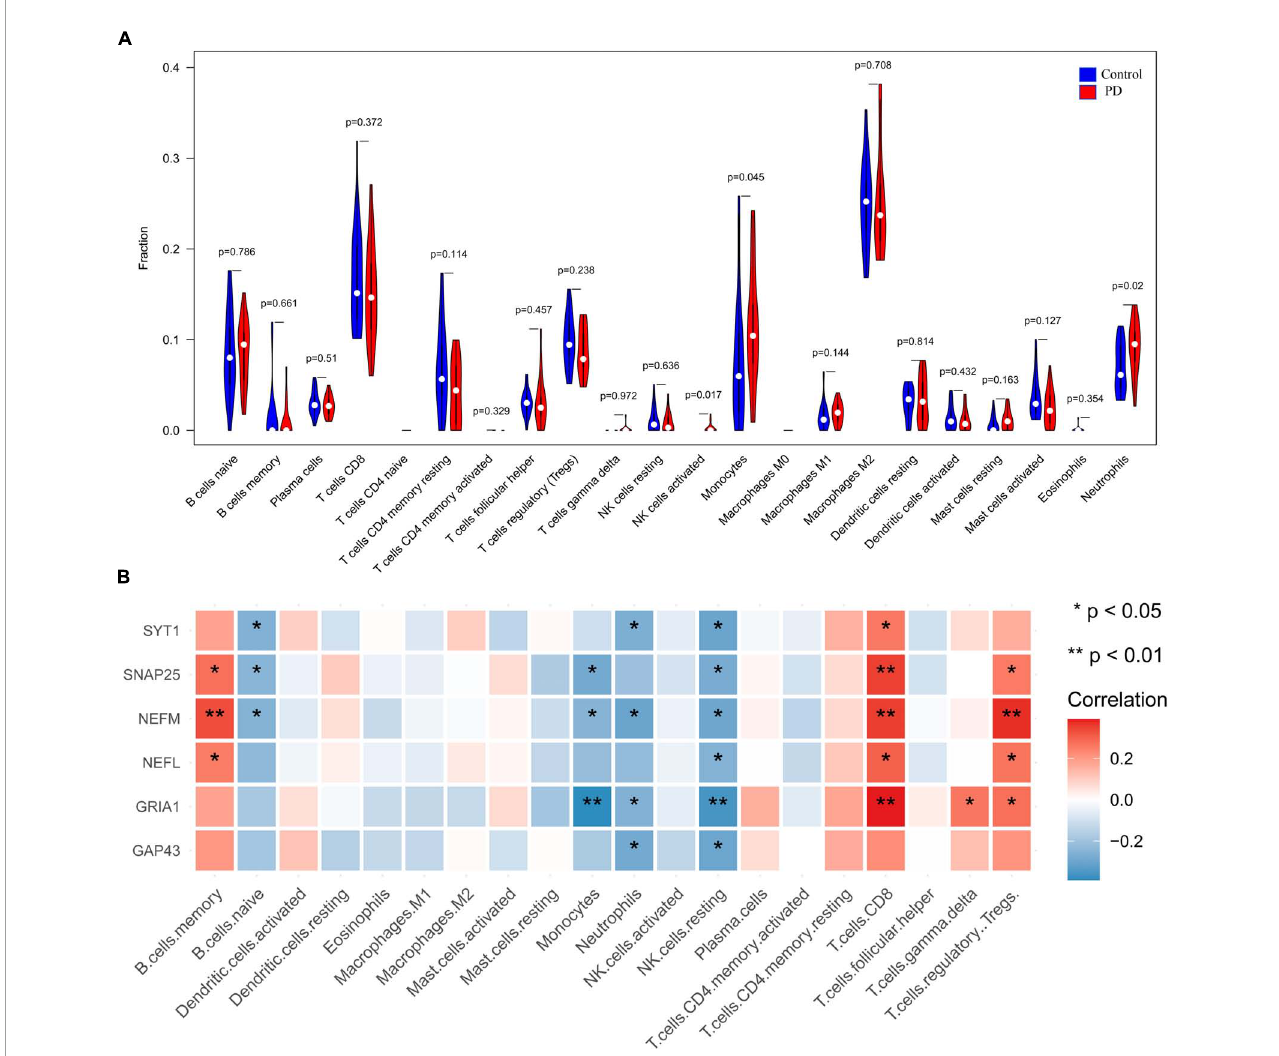
FIGURE9 Visualization and evaluation of immune infiltration levels based on the CIBERSORT algorithm. (A) Comparison of 22 immune cells between PD samples and control samples. (B) Pearson correlation analysis of immune cell infiltration with hub genes (* p < 0.05 and ** p < 0.01). PD, Parkinson’s